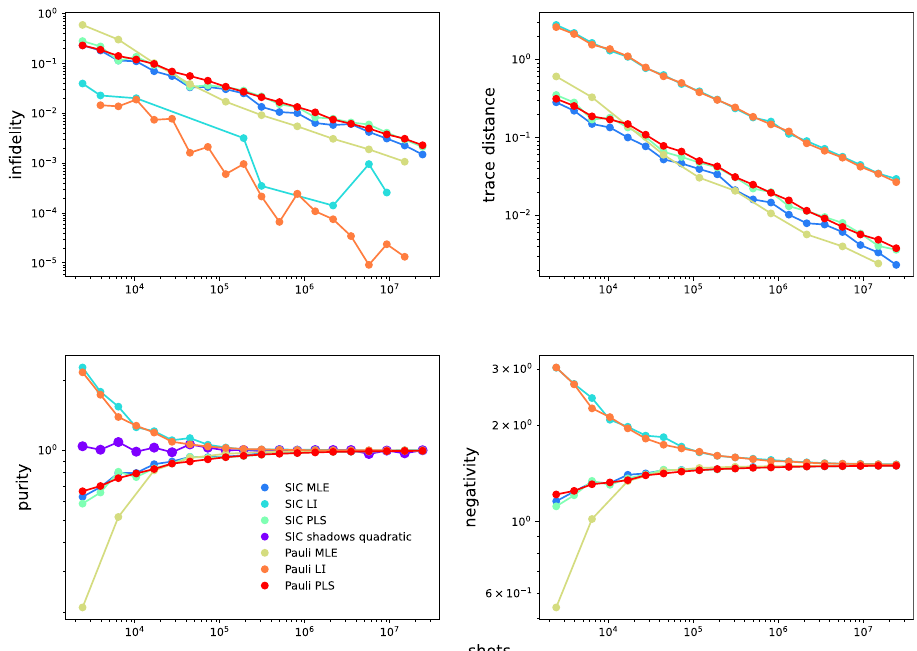
FIG. 12. Numerical simulations incorporating statistical noise covering all tomography approaches. To this extent, quantum shot noise is incorporated via sampling ideal tomography data from a multinomial distribution, with sample sizes corresponding to the number of shots. We additionally present infidelity (1-fidelity) and complementary trace distance following Eq. (A2) and plot in double-logarithmic scale to more clearly visualize several orders of magnitudes. Note that infidelity estimation with LI sometimes delivers unphysical results, indicated by values out of range of the plot. Note that the smaller number of data points for SIC LI comes from ignoring unphysical results, which are more likely when the target state is misaligned with the measurement basis; see Appendix A 7 for